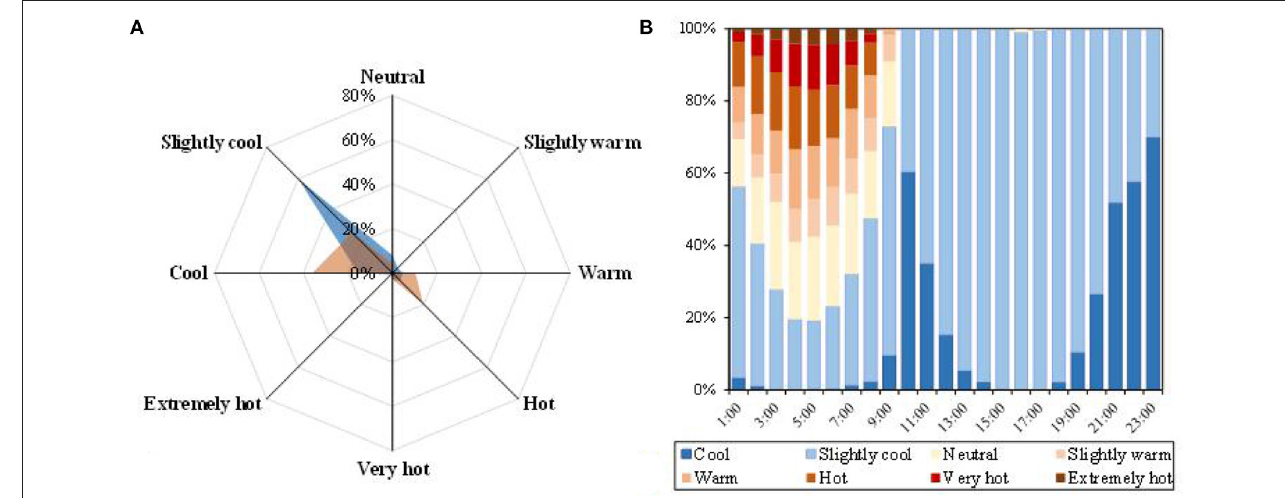
FIGURE 5 | Distribution of thermal comfort level in Chigang community (A) and overtime (B) .